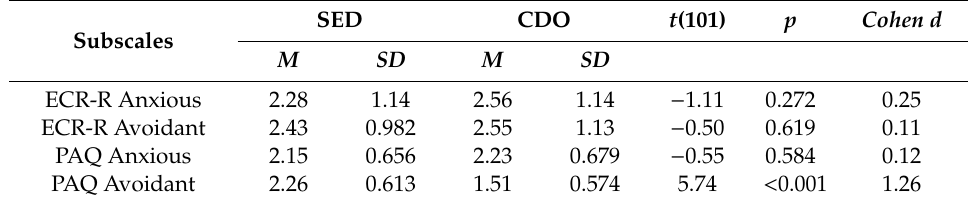
Table 3. Results of Comparisons of Groups on Subscale Variables of Attachment.